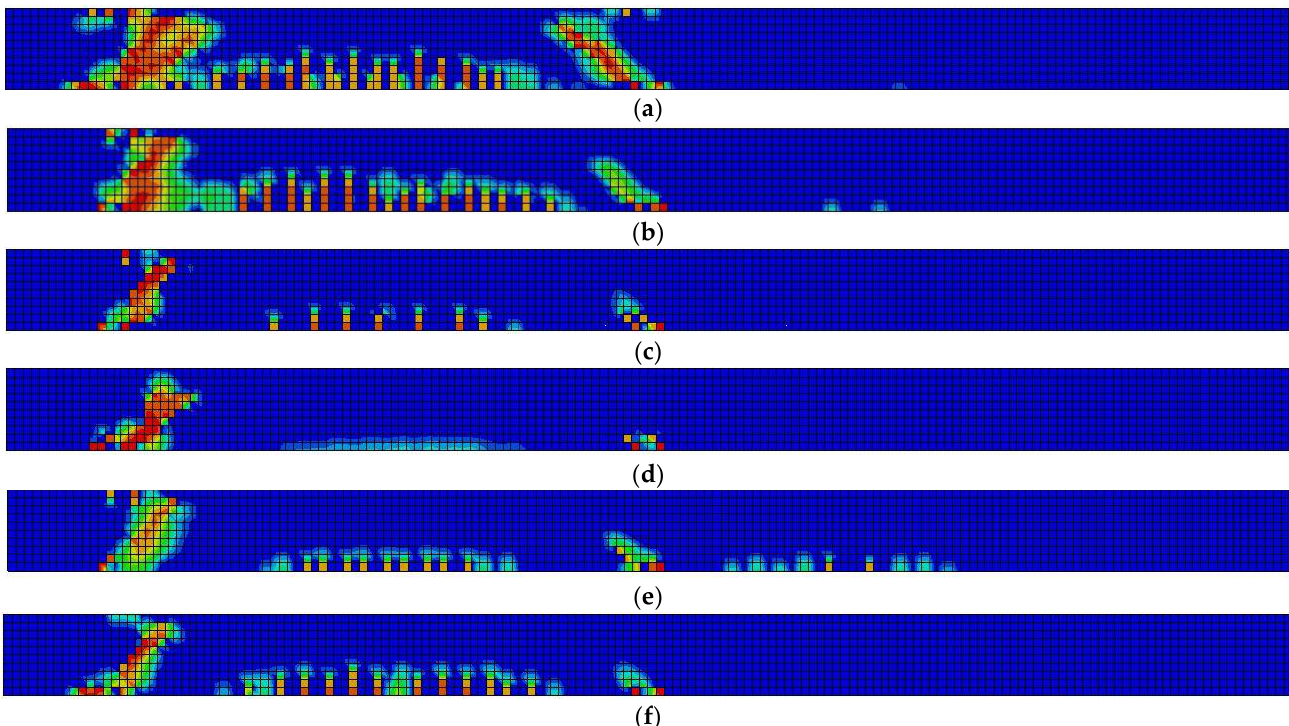
Figure 9. Concrete crack patterns of ( a ) A-S-17, ( b ) CR-S-17, ( c ) CRG5-S-17, ( d ) CRG8-S-17, ( e ) CRG’5-S-17, and ( f ) CRG’8-S-17 beams.